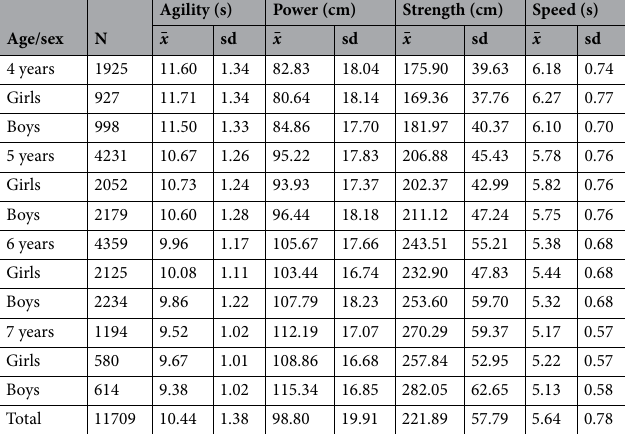
Table 1. Results of individual physical fitness of Polish children aged 4–7